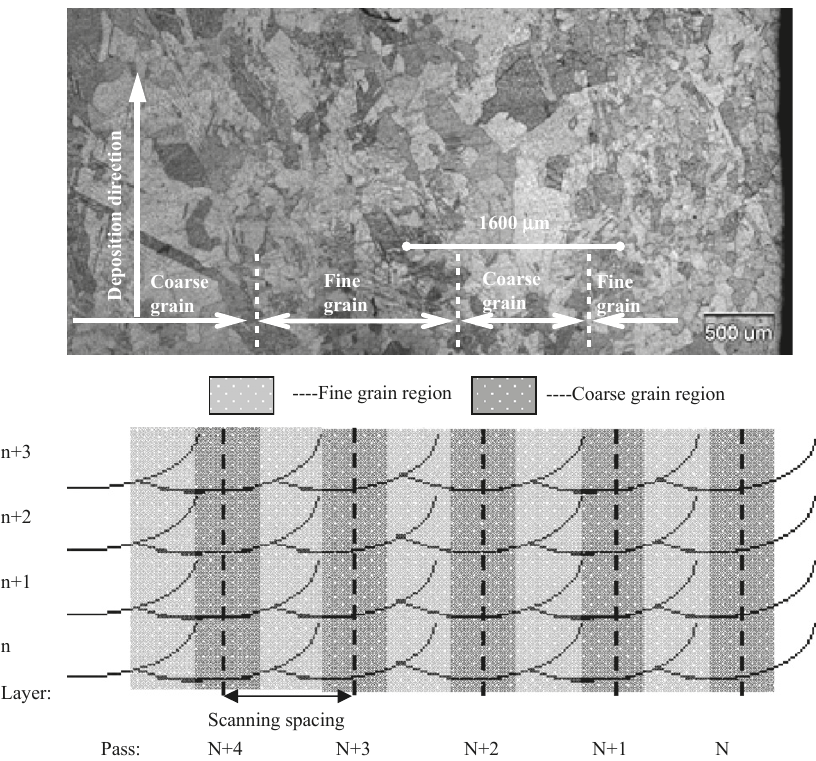
Figure 31. Cross-section of In718 deposit. Finer grain structure is observed in the overlapping regions, and coarser grain structure is observed elsewhere (reproduced with permission from [137]; Copyright © 2011 Elsevier).